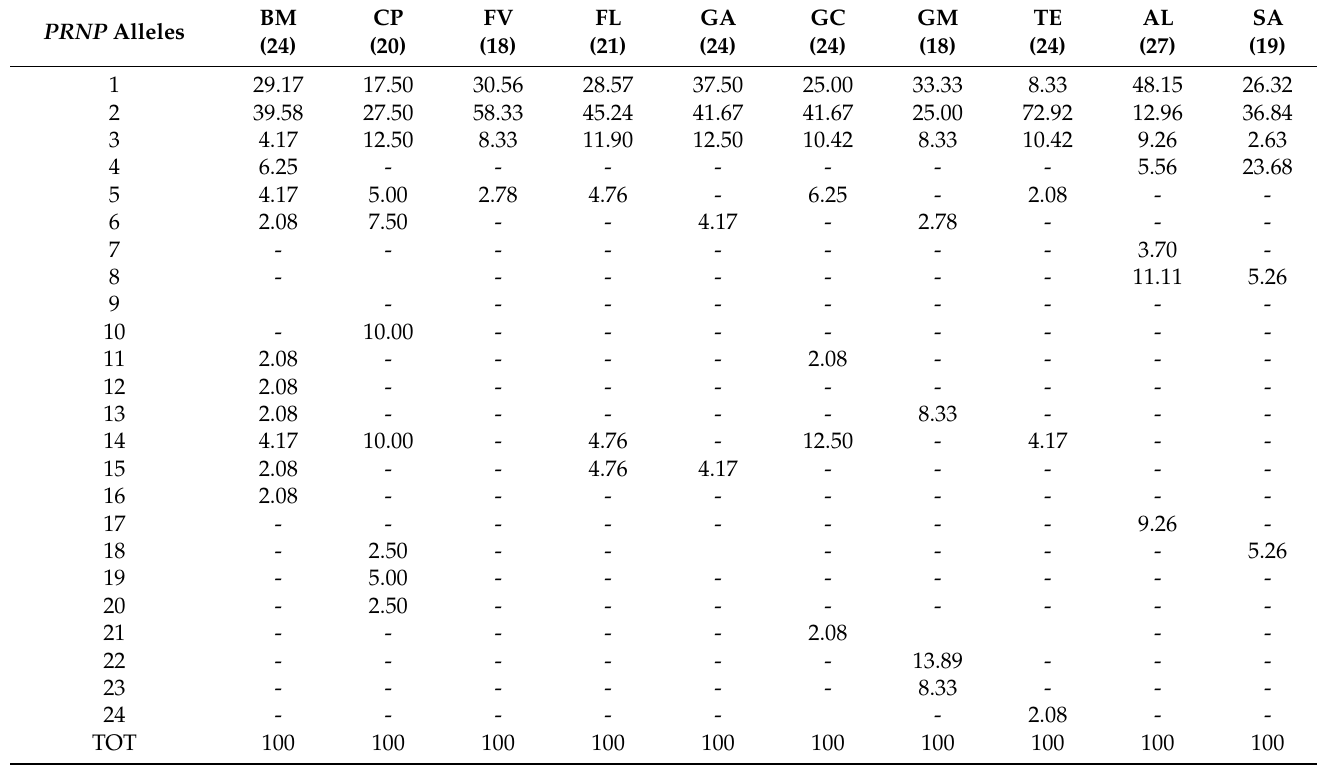
Table 3. PRNP allele frequencies (%) estimated by PHASE 2.1 in the individual goat populations/breeds. The number of animals is indicated in